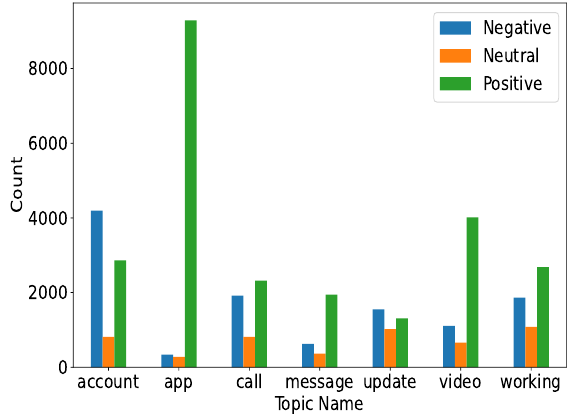
Figure 7. All topic sentiments.